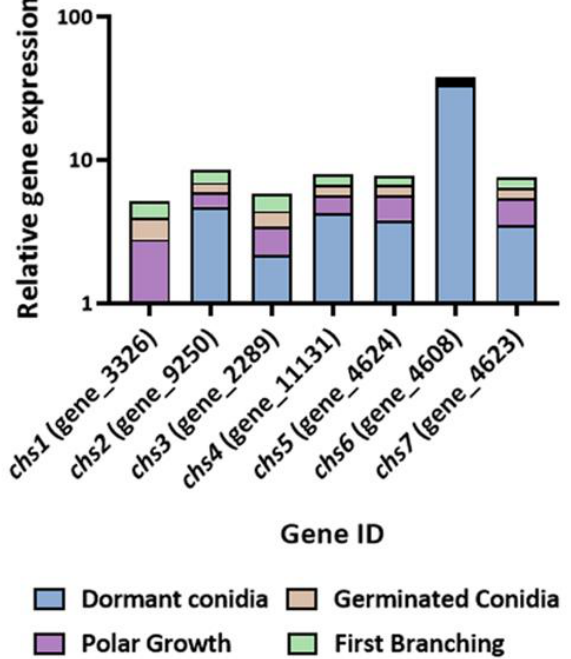
Figure 6. Log relative gene-expression levels of chitin synthases across the four-stage germination time course of Trichoderma asperelloides . Gene expression was determined by RT-PCR. Values shown are based on three biological repeats, with whiskers signifying one standard error. Gene expression was normalized to tef1 . The threshold cycle (2 −ΔΔCT ) method was used to determine fold changes in expression.